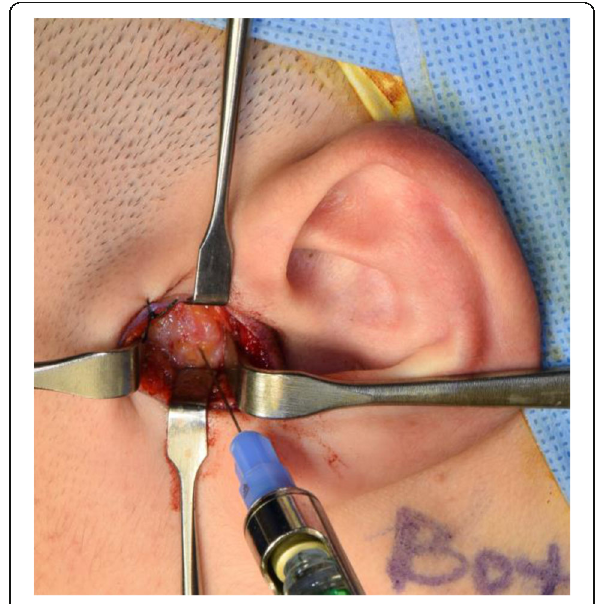
Fig. 3 Intra-articular injection of lidocaine (2% with 1:100,000 epinephrine) to facilitate further dissection of capsular ligament